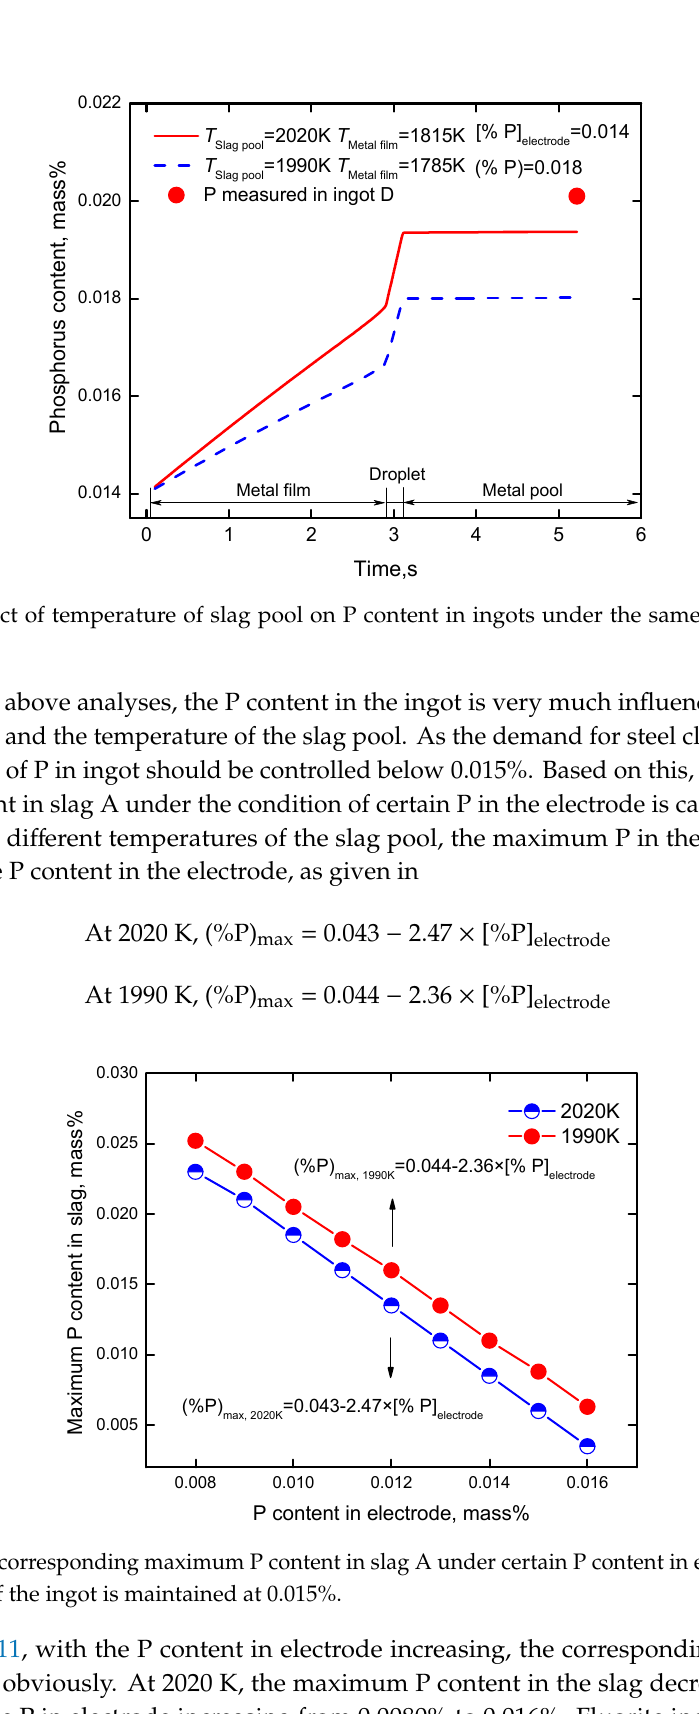
Figure 12. Mechanism of rephosphorization during the electroslag remelting (ESR) process.